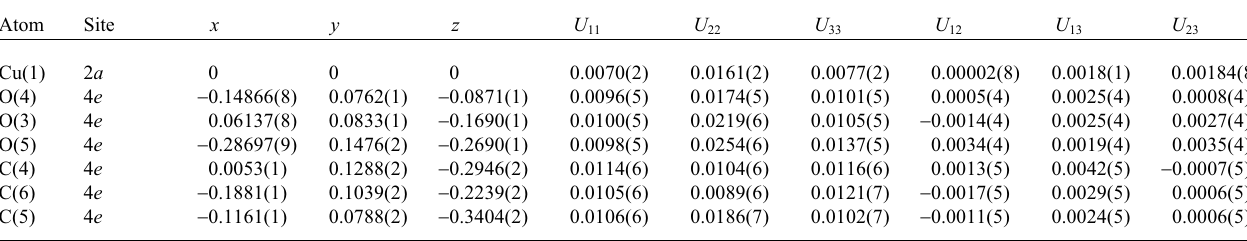
Table 3. Atomic coordinates and displacement parameters (in Å 2 ).